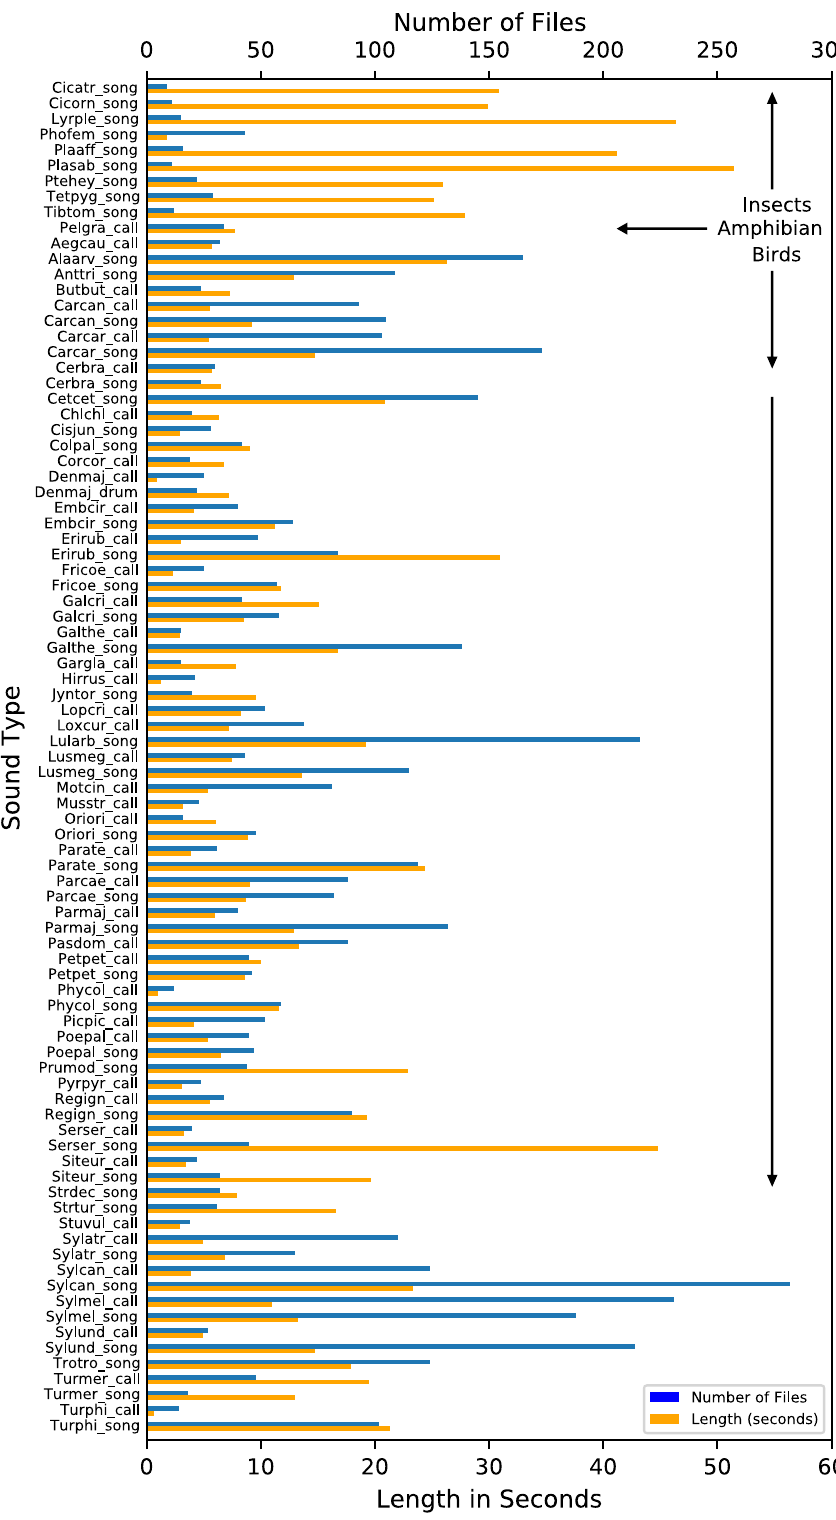
Figure 5. Distribution of sound types by number of calls (number of files) and total length in seconds. Sound types are sorted first by taxonomic group and then by alphabetical